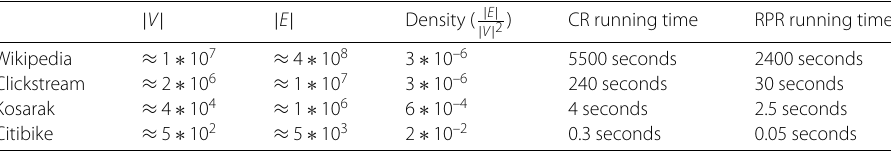
Table 5 A comparative summary of ChoiceRank and R EVERSE PR (abbreviated as CR and RPR,